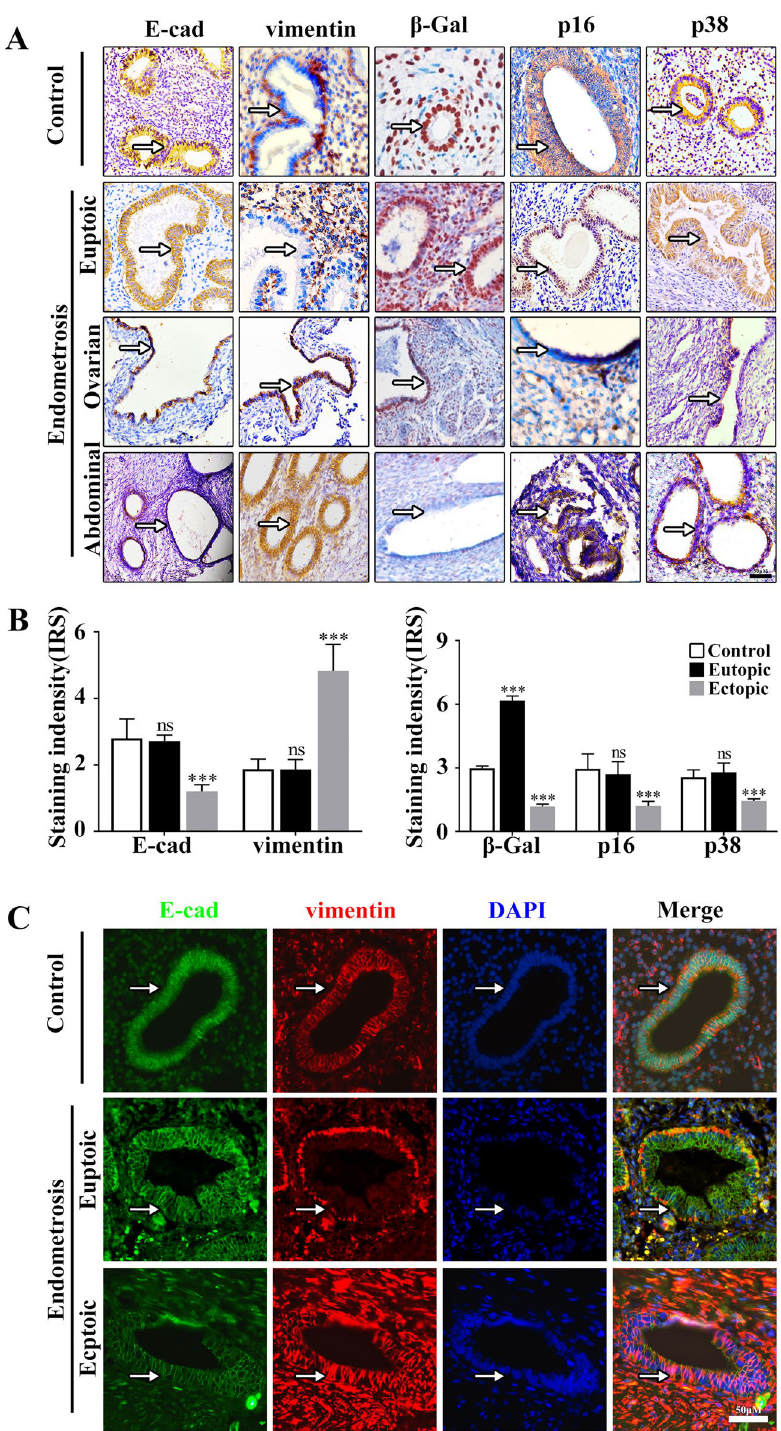
Figure 4. EMT- and senescence-related protein expression in epithelial cells of endometriosis. Immunostaining for E-cad, vimentin, β-gal, p16 and p38 ( A ). The intensity of the immunohistological staining was given an IRS score as the mean ± SEM. The results show that E-cad and vimentin expression was stronger, but β-gal, p16 and p38 expression was weaker in epithelial cells in endometriosis tissues than in the controls ( B ). E-cad and vimentin protein levels were examined by immunofluorescence staining ( C ). Scale bars = 50 µm in ( A , C ). *** p <